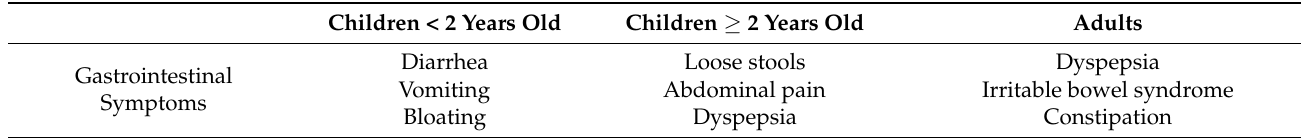
Table 3. Age related major clinical findings at the celiac disease